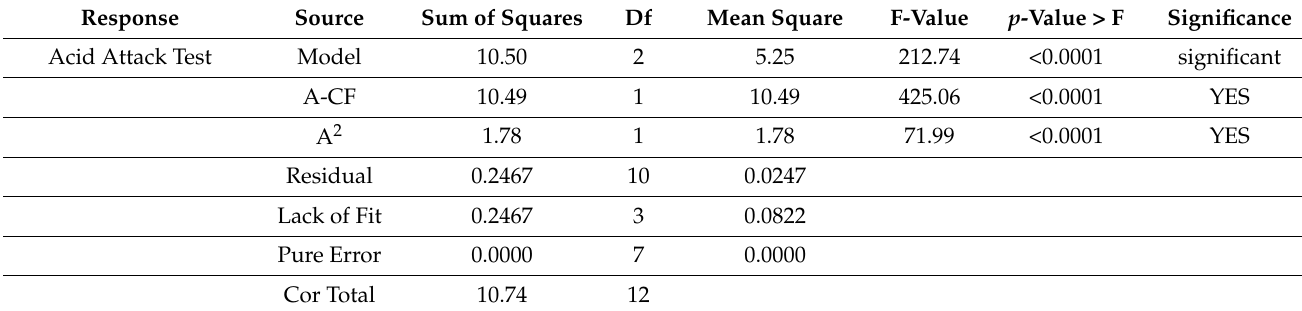
Table 9. ANOVA Results for the Variable Response 28-day Acid Attack Test.